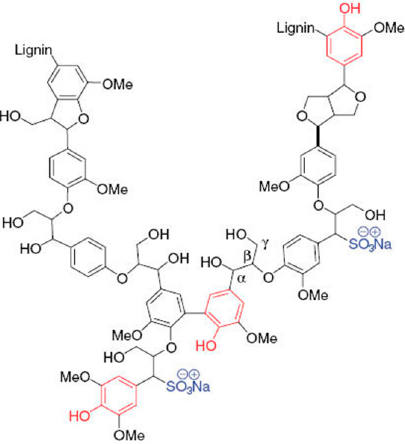
Figure 1. General chemical structure of lignosulfonate. Phenolic groups are depicted in red and sulfonate groups in blue.